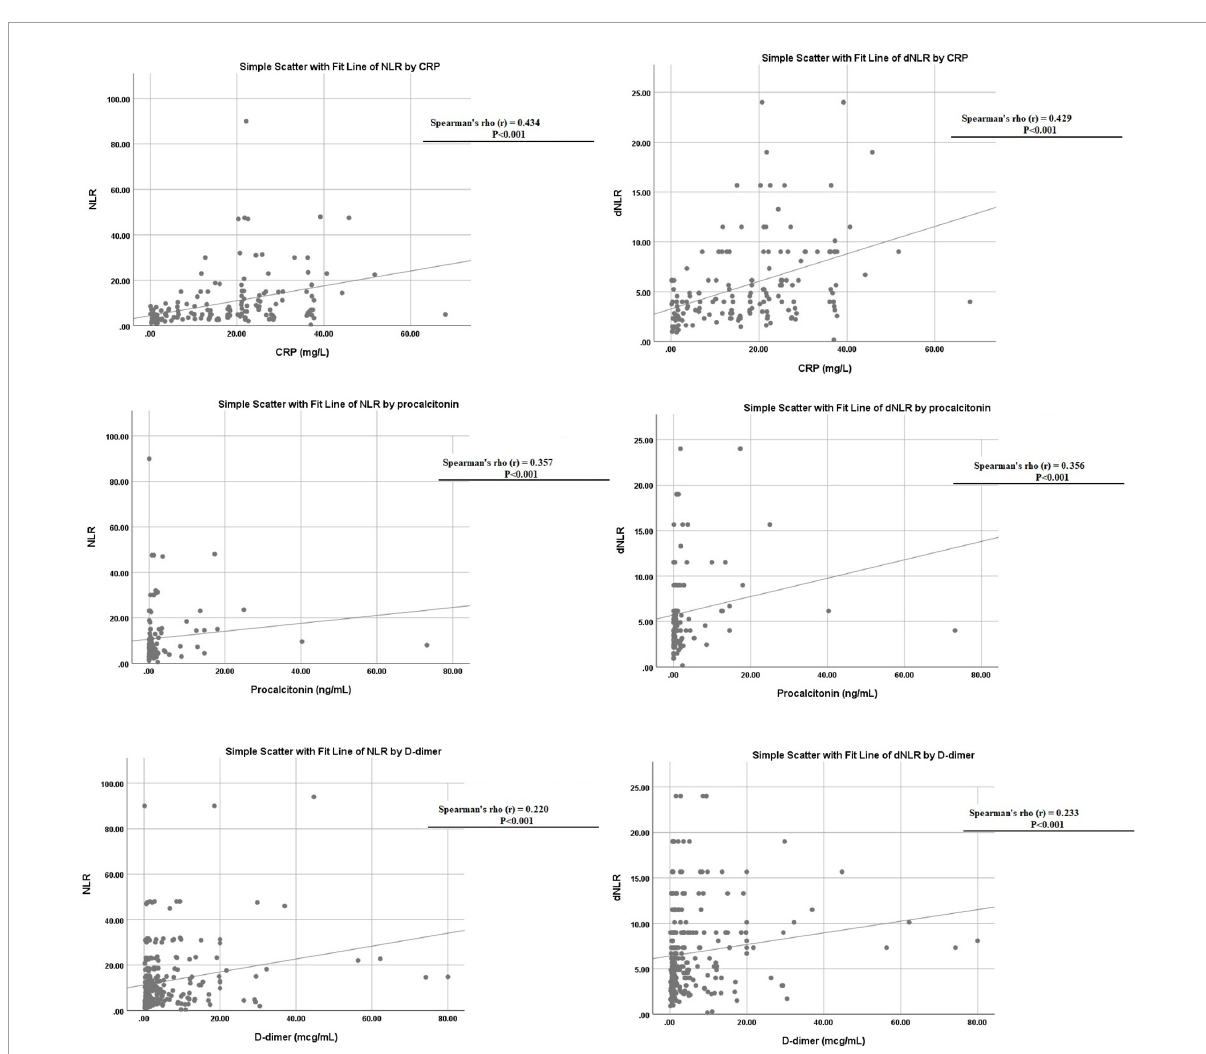
FIGURE4 Linear correlation of neutrophil to lymphocyte ratio (NLR) and derived NLR (dNLR) with C-reactive protein (CRP), D-dimer, and procalcitonin